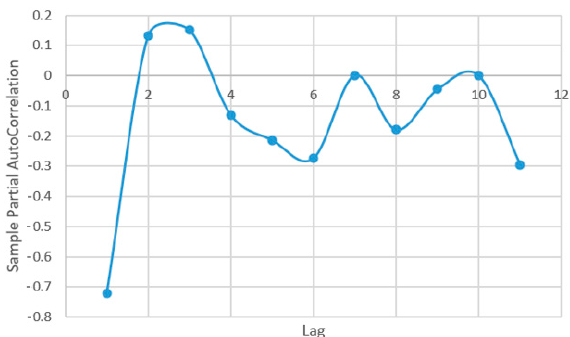
Figure A9. The AC with transformation in square roots—BH series.